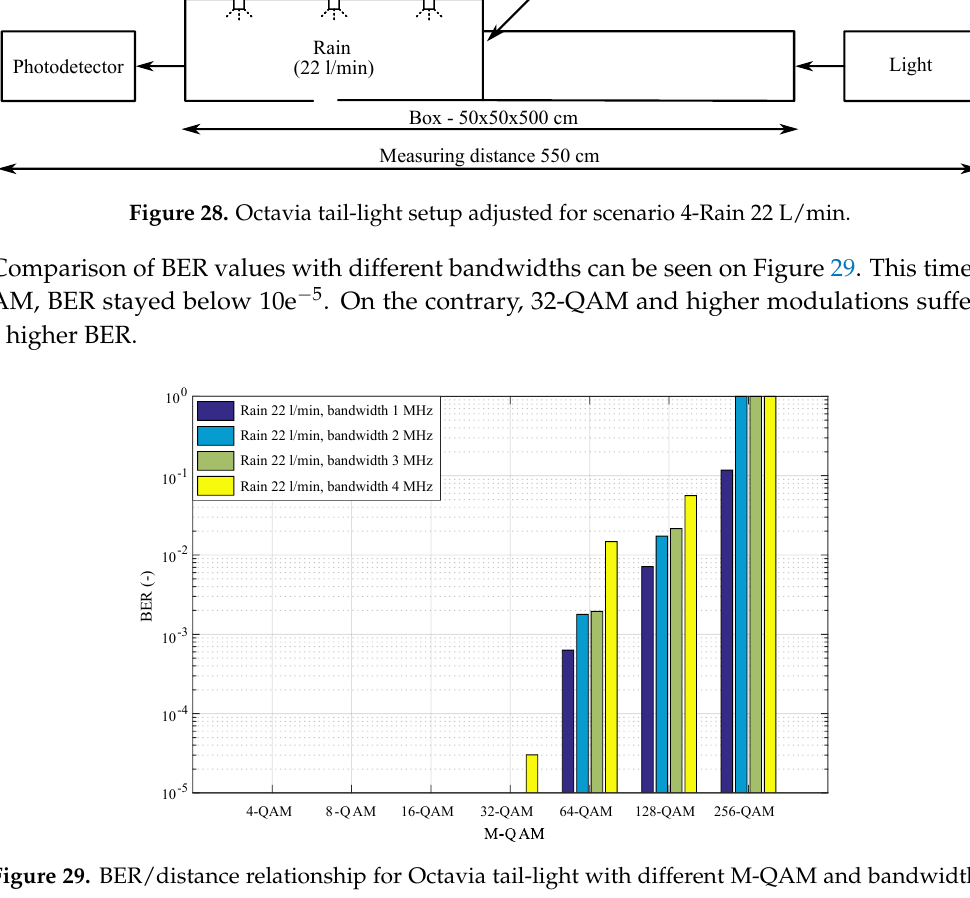
Figure 29. BER/distance relationship for Octavia tail-light with different M-QAM and bandwidths —scenario 4-Rain 22